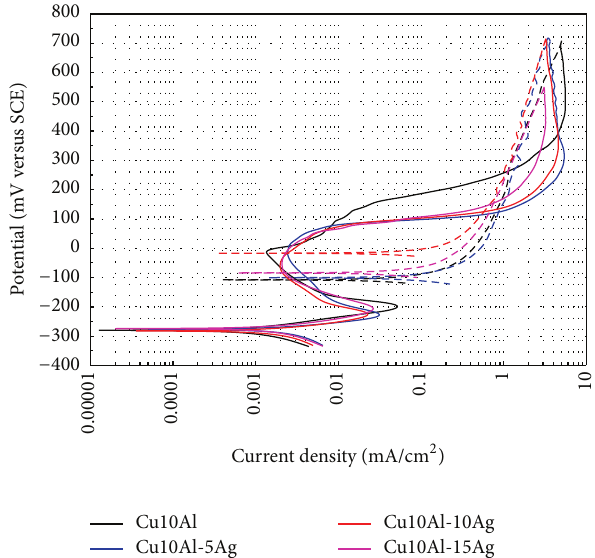
Figure 4: Cyclic polarization curves for the Cu10Al- 𝑥 Ag ( 𝑥 = 0, 5, 10, and 15) alloys in artificial saliva at 37 ∘ C (d 𝐸 /d 𝑡 = 0.167 mV/s).